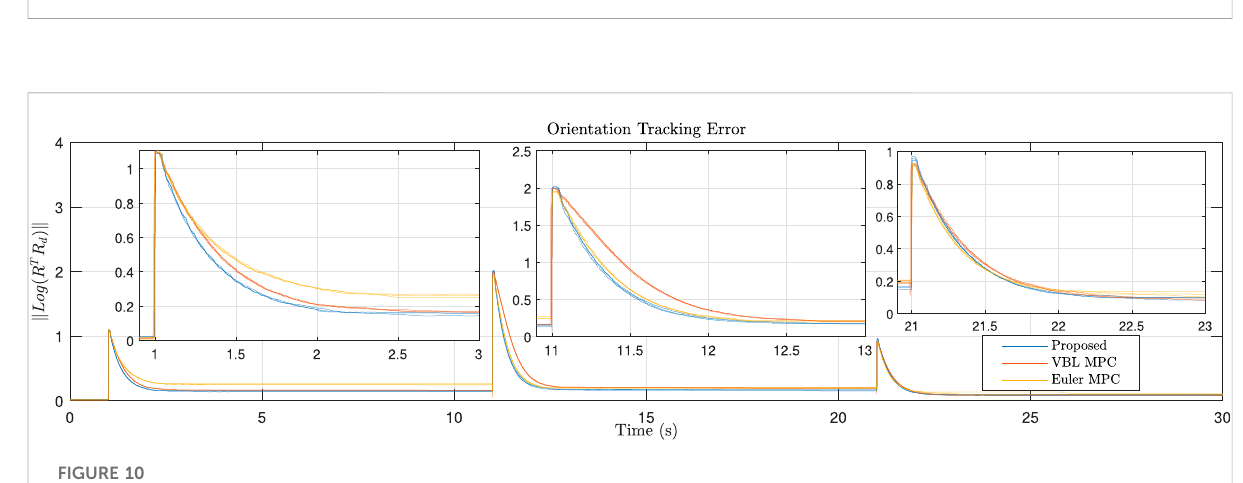
FIGURE 9 Referencesignalforrollandyawangletracking.From1to11s,therobotrollchangesfrom0to-57.3 ° andyawchangesfrom0to28.5 ° .Thenthe robot leans to the opposite side for 10